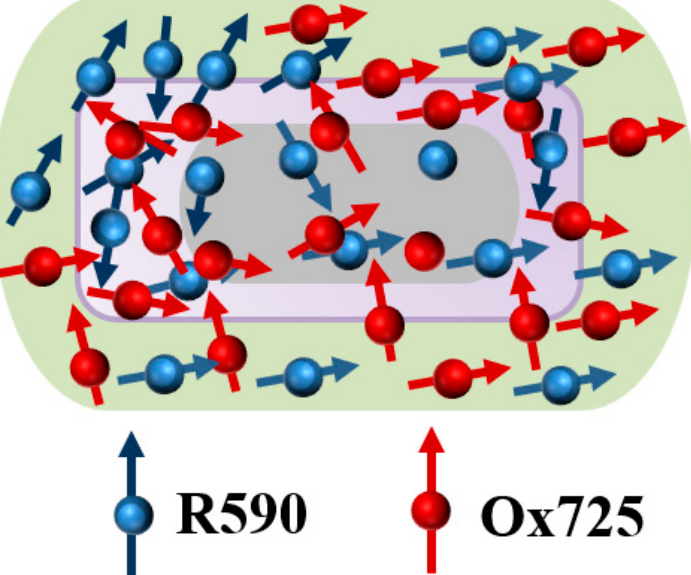
Figure 10. Schematic showing the Au nanorod@Ag core–shell nano-system coated with SiO 2 mono- layer. Adapted from Ref. [73].